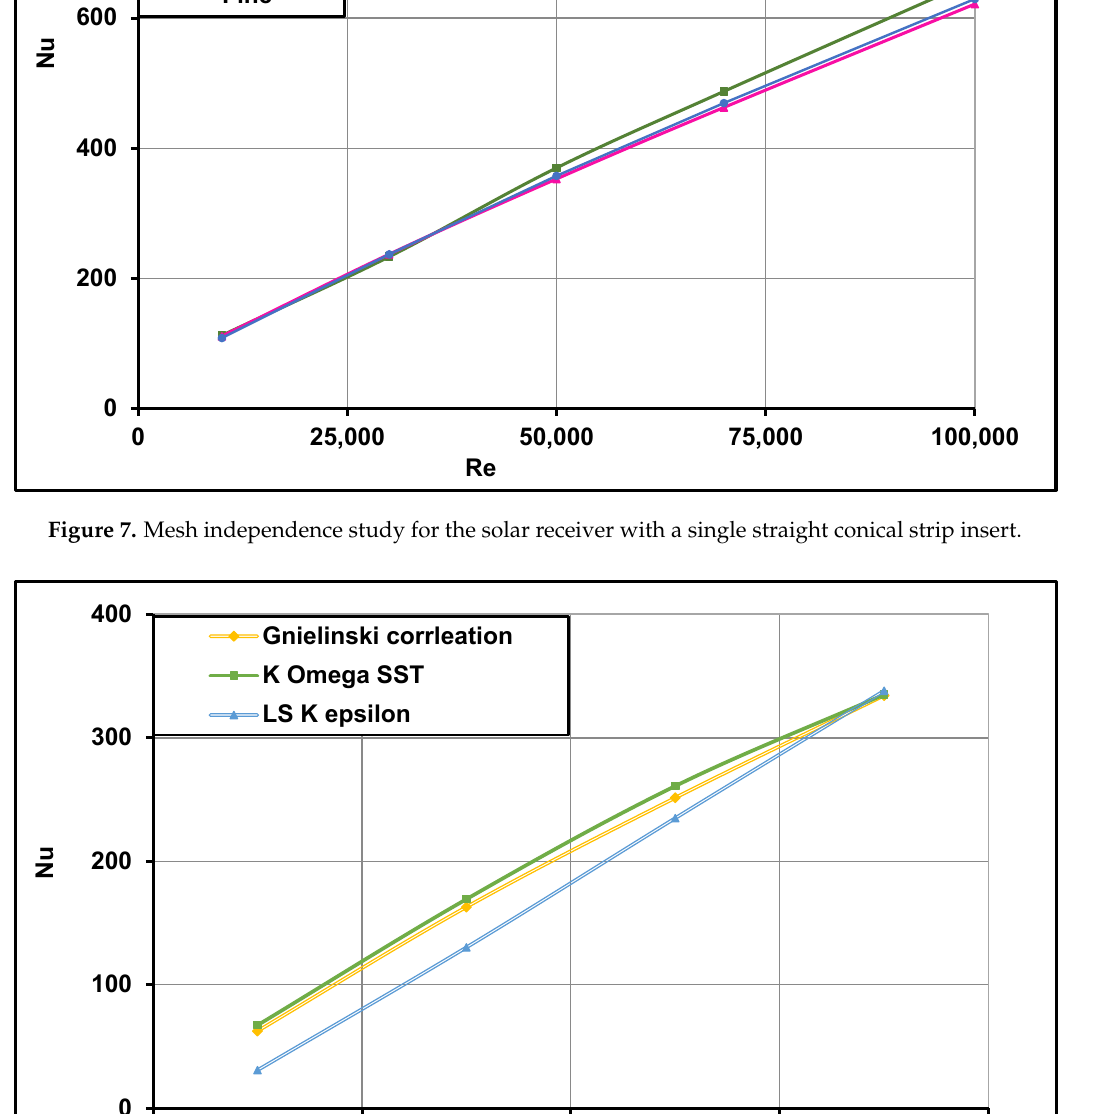
Figure 8. Computed average Nu number comparisons with measurements of Gnielinski [46].